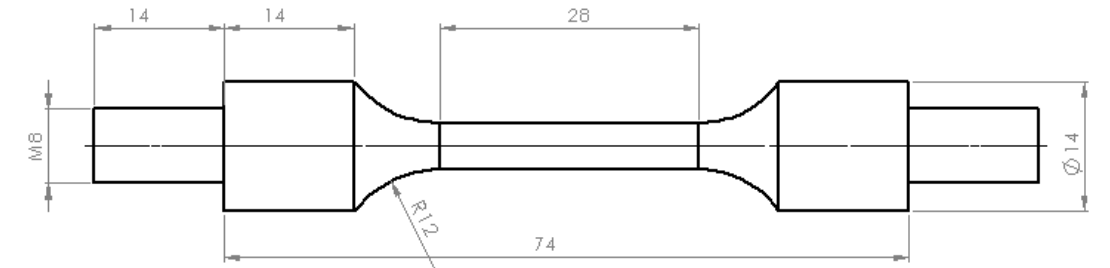
Figure 2. Geometry of specimen for tensile tests.